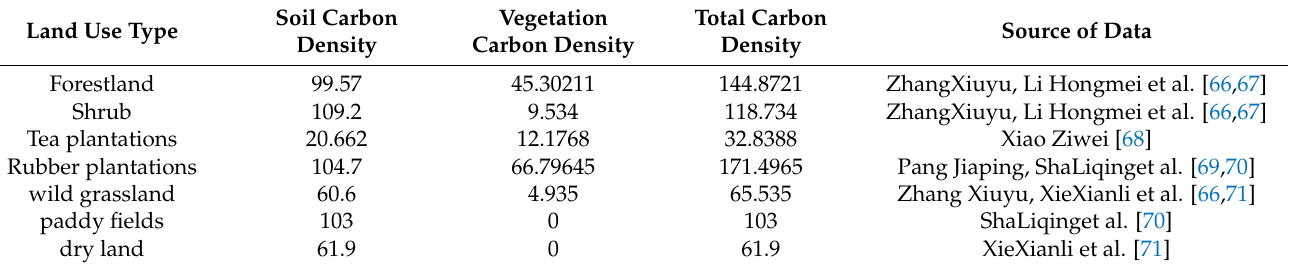
Table 2. Parameters in carbon stocks evaluation (ton